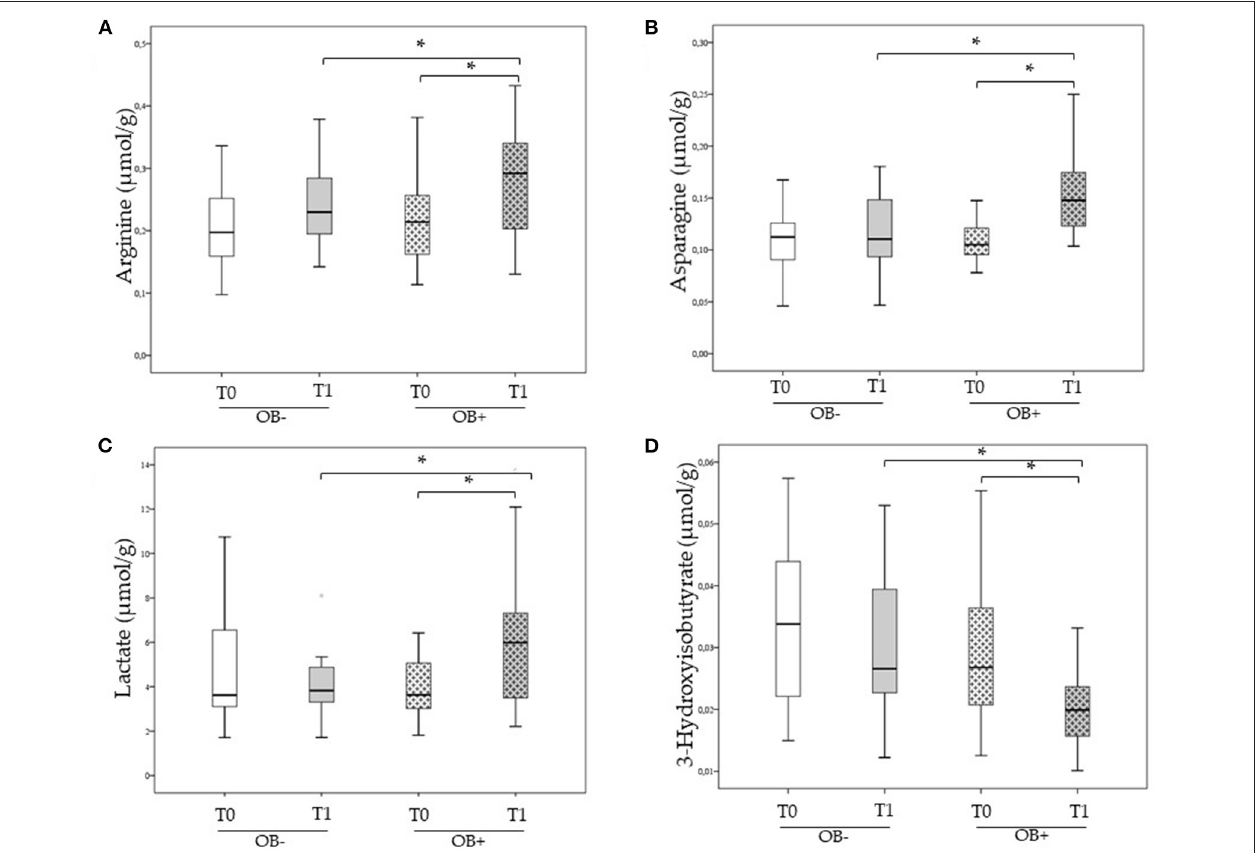
FIGURE 1 | (A–D) Serum Arginine, Asparagine, Lactate, and 3-Hydroxyisobutirate concentration in SARS-CoV-2 infected patients receiving and not receiving oral bacteriotherapy treatment at T0 and T1. (A) Comparison of Arginine serum concentration at T0 and T1 between SARS-CoV-2 infected patients treated or not treated with OB. (B) Comparison of Asparagine serum concentration at T0 and T1 between SARS-CoV-2 infected patients treated or not treated with OB. (C) Comparison of Lactate serum concentration at T0 and T1 between SARS-CoV-2 infected patients treated or not treated with OB. (D) Comparison of 3-Hydroxyisobutirate serum concentration at T0 and T1 between SARS-CoV-2 infected patients treated or not treated with OB. Data were analyzed using the Mann–Whitney U -test and the Wilcoxon signed-rank test for paired samples. *Statistically